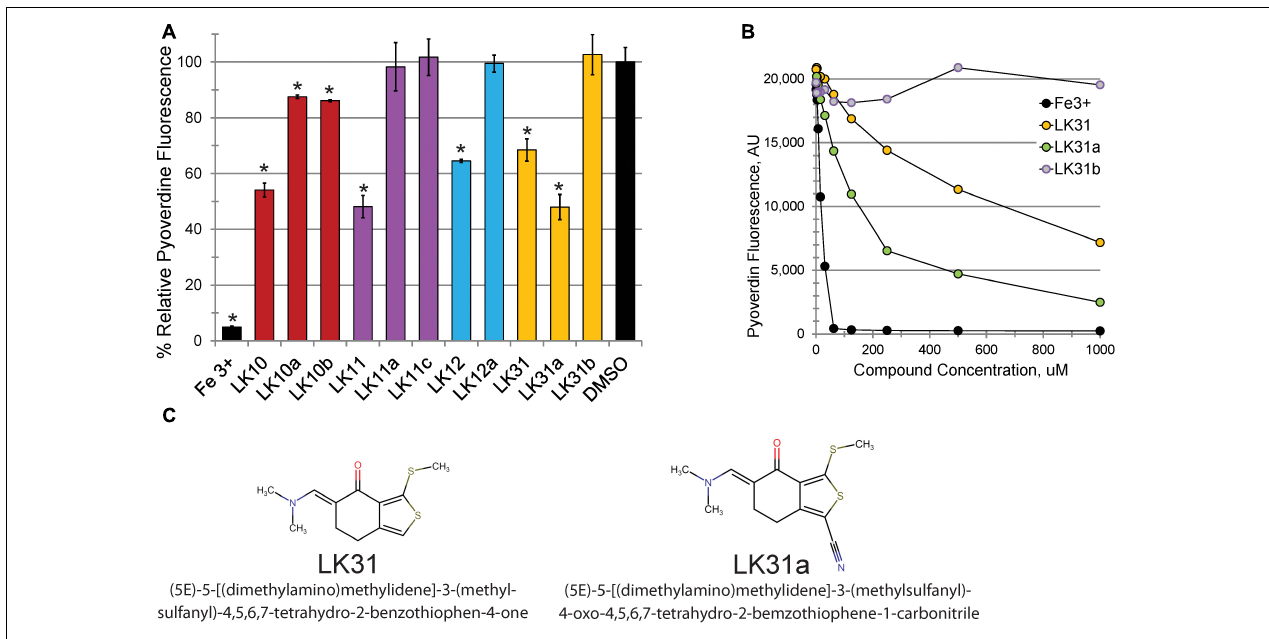
FIGURE 3 | Selected hits show dosage-dependent pyoverdine fluorescence quenching. (A,B) Fluorescence of bacteria-free, pyoverdine-rich filtrate after 5 min incubation with the compounds indicated at either fixed (250 µ M, A ) or varying (B) concentrations. DMSO. (C) Structural comparison of a parent compound (LK31) and an analog with improved efficiency (LK31a). At least three biological replicates were performed for A,B . p -values were calculated using Student’s t -test, ∗ p <